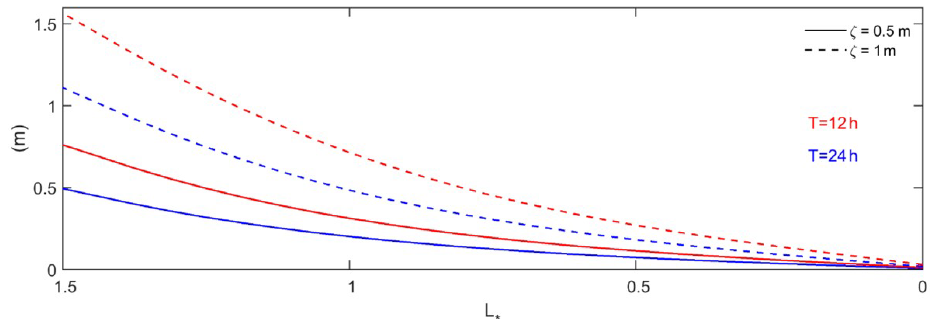
Figure 7. The effects of wave period (i.e., 12 and 24h) and amplitude (0.5 and 1m at the ocean boundary L ∗ = 0) on tidally averaged water level for 5m depth channel in an idealized one-sinusoidal-wave model for θ = 1. The vertical axis is the tidally averaged water level, and the horizontal axis represents the estuary length normalized by the convergence length scale (i.e., L ∗ = x/L e ).